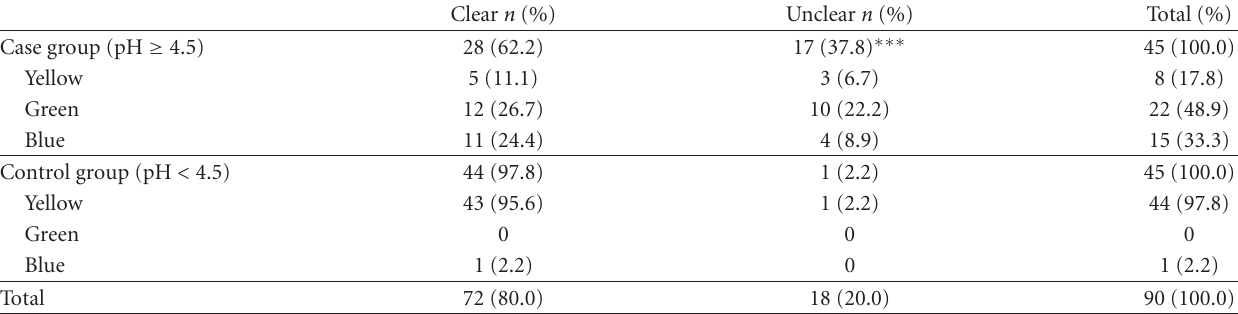
Table 3: Results of VS-SENSE test and colour classification in clear and unclear, according to the agreement among observers.